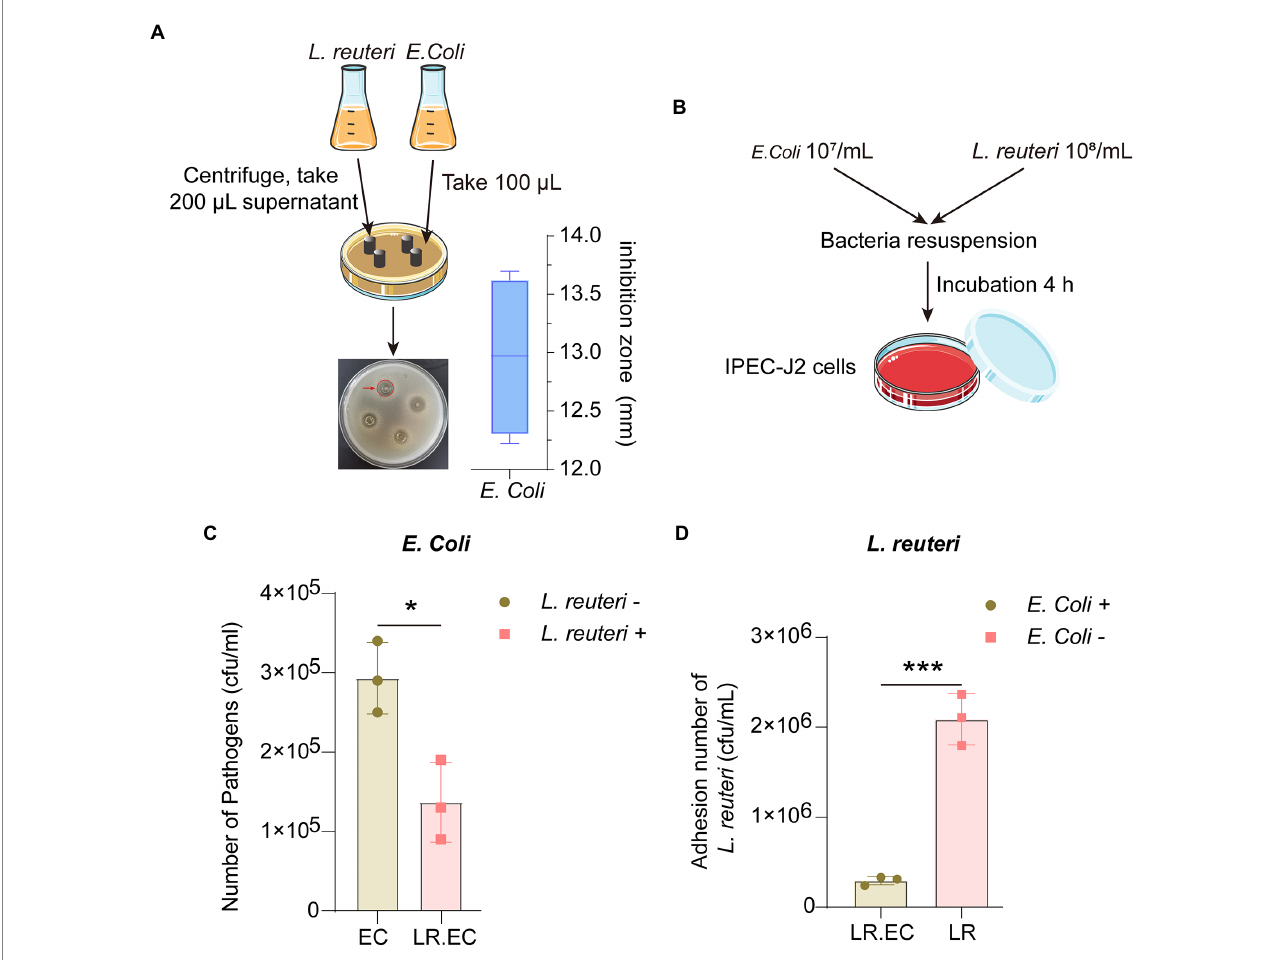
FIGURE 1 Antibacterial effect of L. reuteri in vitro . (A) Zone diameters of inhibition of L. reuteri against E. coli F18ac. (B) Workflow of adhesion ability assay of bacteria to IPEC-J2 cells. (C) Effect of L. reuteri on E. coli F18ac adhesion to IPEC-J2 cells. (D) Adhesion of L. reuteri to IPEC-J2 cells in E. coli F18ac (vs. control). * p < 0.01; *** p <